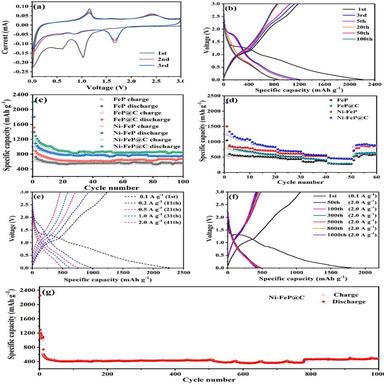
CV curves for the first three cycles of Ni-FeP@C at 0.2 mV s − 1 (a); Galvanostatic discharge/charge curves of Ni-FeP@C at 0.1 A g− 1 (b); Cycling performances of FeP, FeP@C, Ni-FeP and Ni-FeP@C Ni-FeP@C at 0.1 A g− 1 (c); Rate performances of FeP, FeP@C, Ni-FeP and Ni-FeP@C (d); Charge-discharge profiles of Ni-FeP@C electrode at different current densities (e and f); Long-cyclic performance of Ni-FeP@C at 2.0 A g− 1 (g).